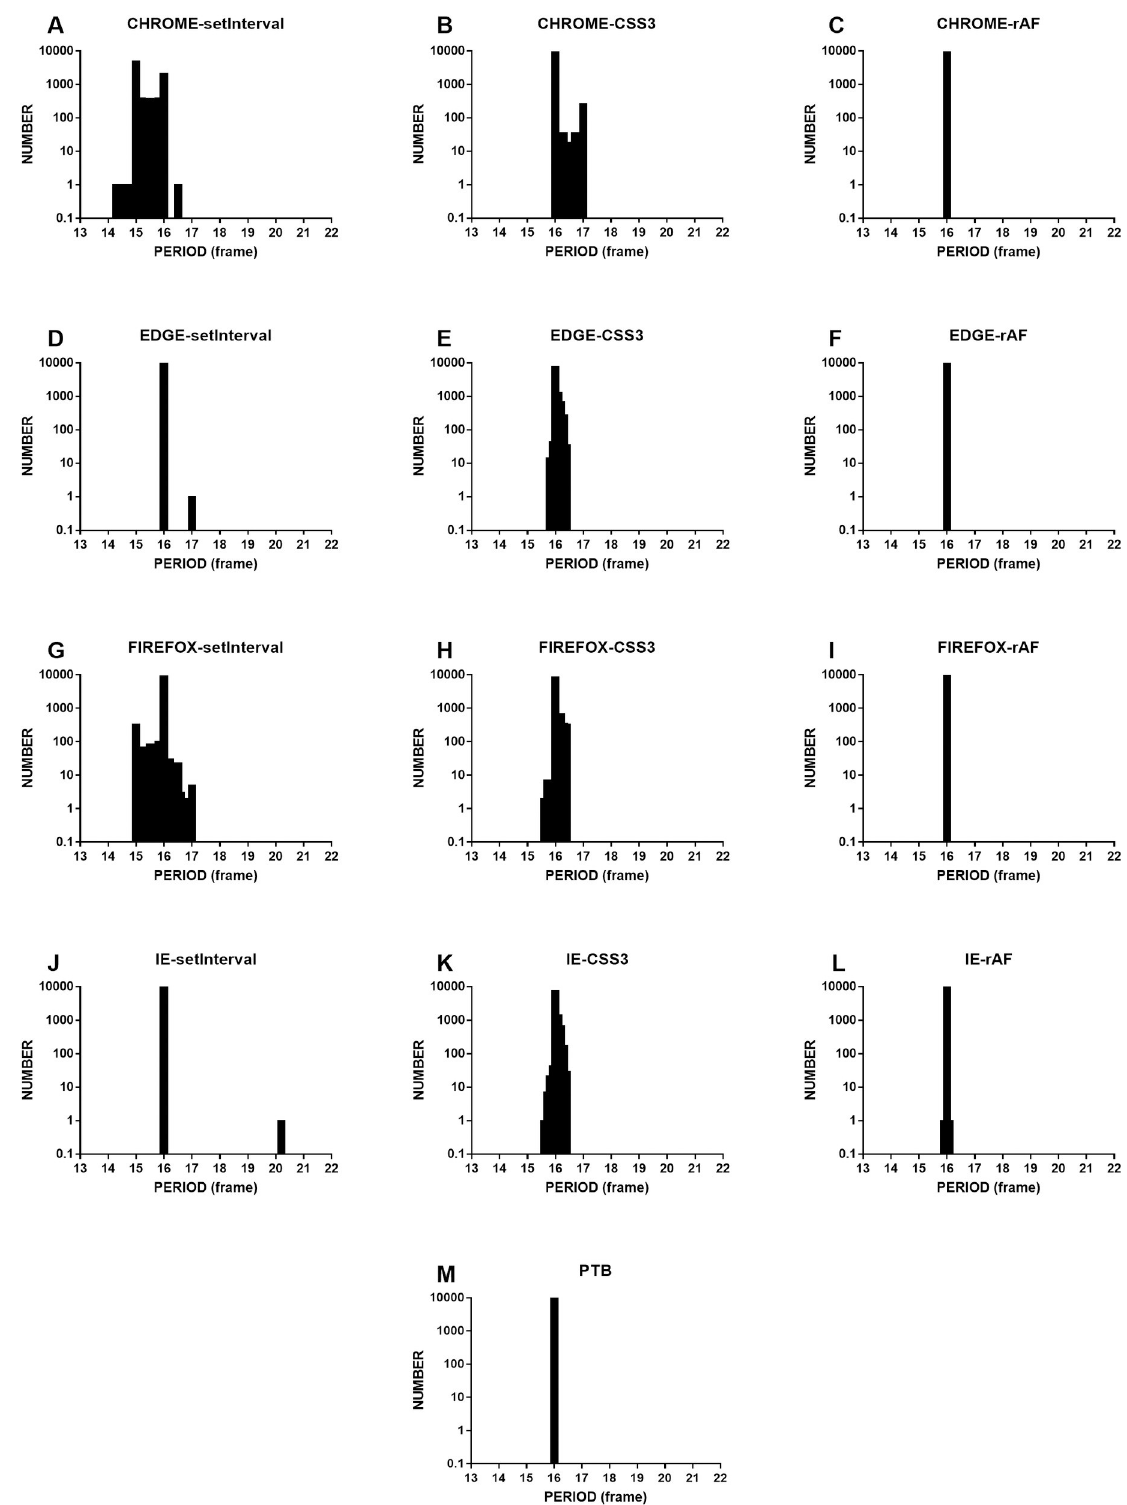
Fig 4. The histograms show the period data for grating experiments in Chrome, Firefox, Edge, and Internet Explorer (hereafter, IE) using setInterval, CSS3, and rAF. The bottom of the figure shows the PTB period as the gold standard. All data ran at real-time priority. The unit of the abscissa is frames (screen refresh rate is 60 Hz), and the ordinate indicates the number of grating appearances. The three